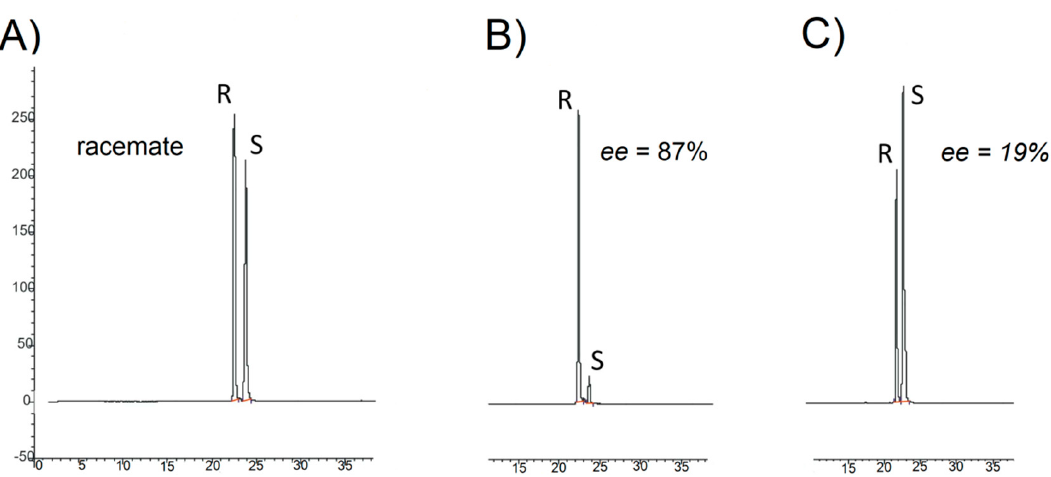
Figure 1. Chromatograms from chiral HPLC analysis of racemic diethyl 2,3 ‐ dipalmitoyloxypropylphosphonate ( 1 ) ( A ) and the products of PLA 2 ‐ catalyzed hydrolysis of racemic phosphonate 1 : ( R ) ‐ hydroxyphosphonate 2 (analyzed after derivatization to ( R ) ‐ phosphonate 1 ) ( B ) and unreacted ( S ) ‐ phosphonate ( 1 ) ( C ).